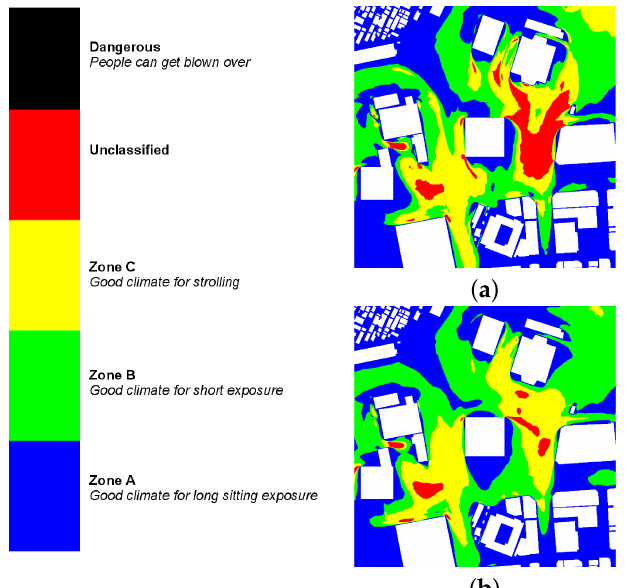
Figure 18. Visualization of the different wind comfort zones following ( a ) Melbourne criteria based on the reference data ( α = 1, θ = 0) and ( b ) Melbourne criteria based on the UQ